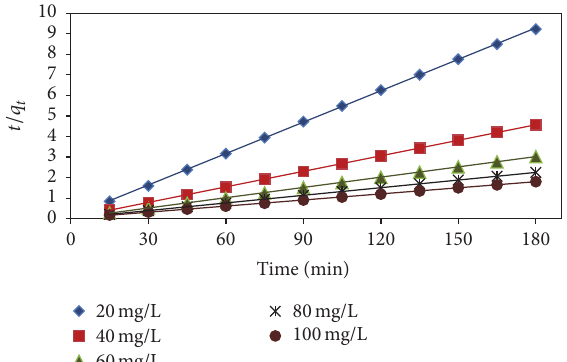
Figure 17: Pseudo-first-order kinetic model for adsorption RB-5 in binary system with RR-RB (temp. = 25 ∘ C, speed = 200 rpm, dose = 0.1g/100 mL, and con. of RR-RB = con. of RB-5).